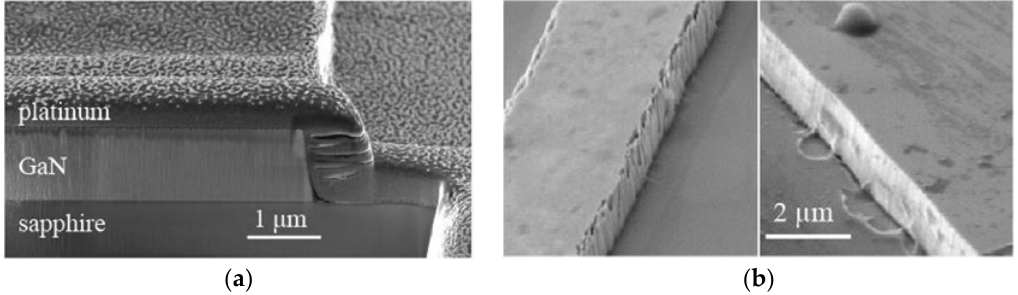
Figure 1. ( a ) Cross-sectional scanning electron microscopy (SEM) image of a III-polar GaN waveguide. The image is taken at an oblique angle of 52°. A platinum layer has been deposited prior to making the cross-section in order to protect the uppermost part of the waveguide during the focused ion beam (FIB) etching. The measured thickness of the GaN waveguides used in the experiment is around 1150 nm. ( b ) Comparison of the side roughness of GaN waveguides which are 3 μ m ( left ) and 20 μ m ( right ) wide. A higher sidewall roughness is observed for narrower waveguides. As a result, the GaN waveguides used for second-harmonic generation (SHG) were at least 10 μ m wide.